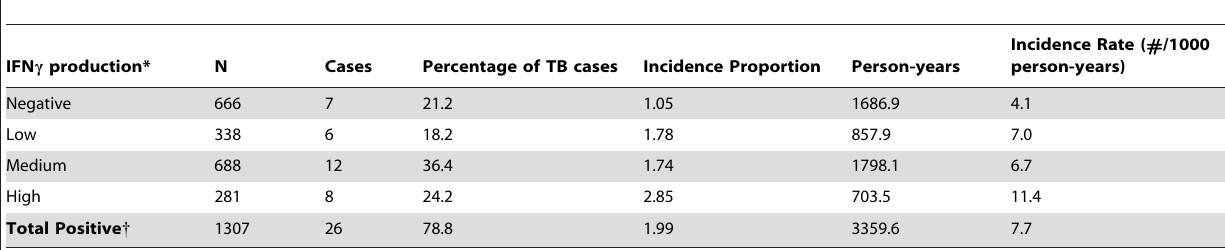
Table 6. Incidence of active tuberculosis in household contacts and IFN c production levels at baseline.